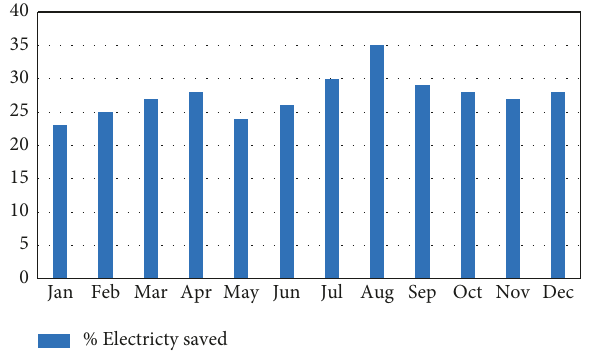
Figure 6: % of electricity saved throughout the